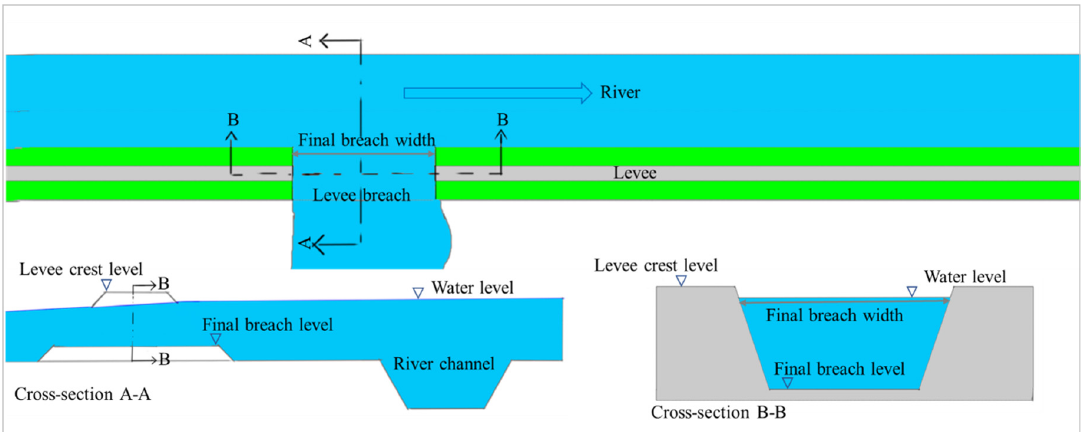
Figure 2. Sketch: Definition of levee breach (not to scale).